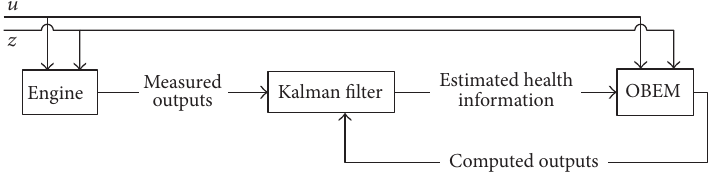
Figure 5: General structure of an